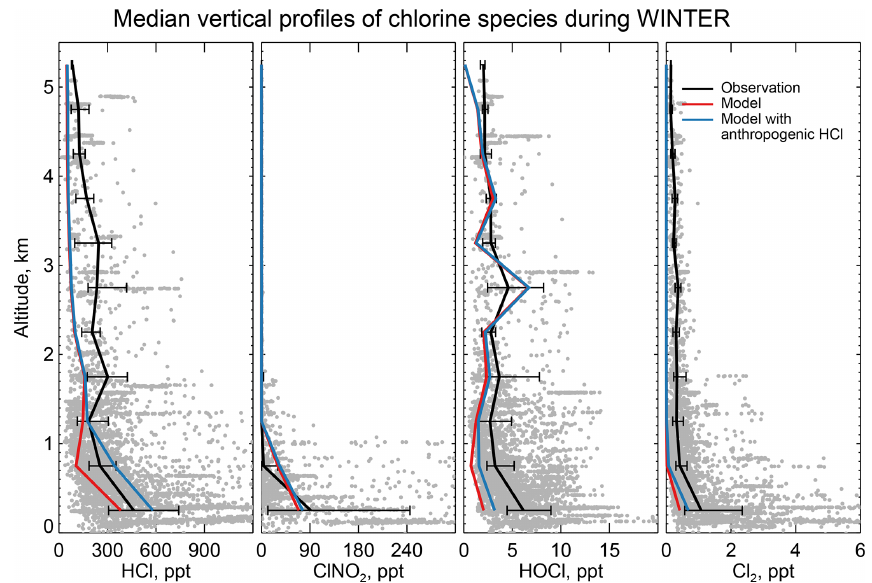
Figure 6. Vertical profiles of HCl, nighttime ClNO 2 , HOCl, and Cl 2 mixing ratios during the WINTER campaign over the eastern US and offshore in February–March 2015. Observations from Haskins et al. (2018) are shown as individual 1min data points, with medians and 25th–75th percentiles in 500m vertical bins. Measurements below the detection limit are treated as the median of 0 and detection limit. ClNO 2 data exclude daytime (10:00–16:00 local) when mixing ratios are near zero in both the observations and the model (Fig. 7). Model values are shown as medians sampled along the flight tracks. Also shown are results from a sensitivity simulation including the anthropogenic chlorine inventory of McCulloch et al.